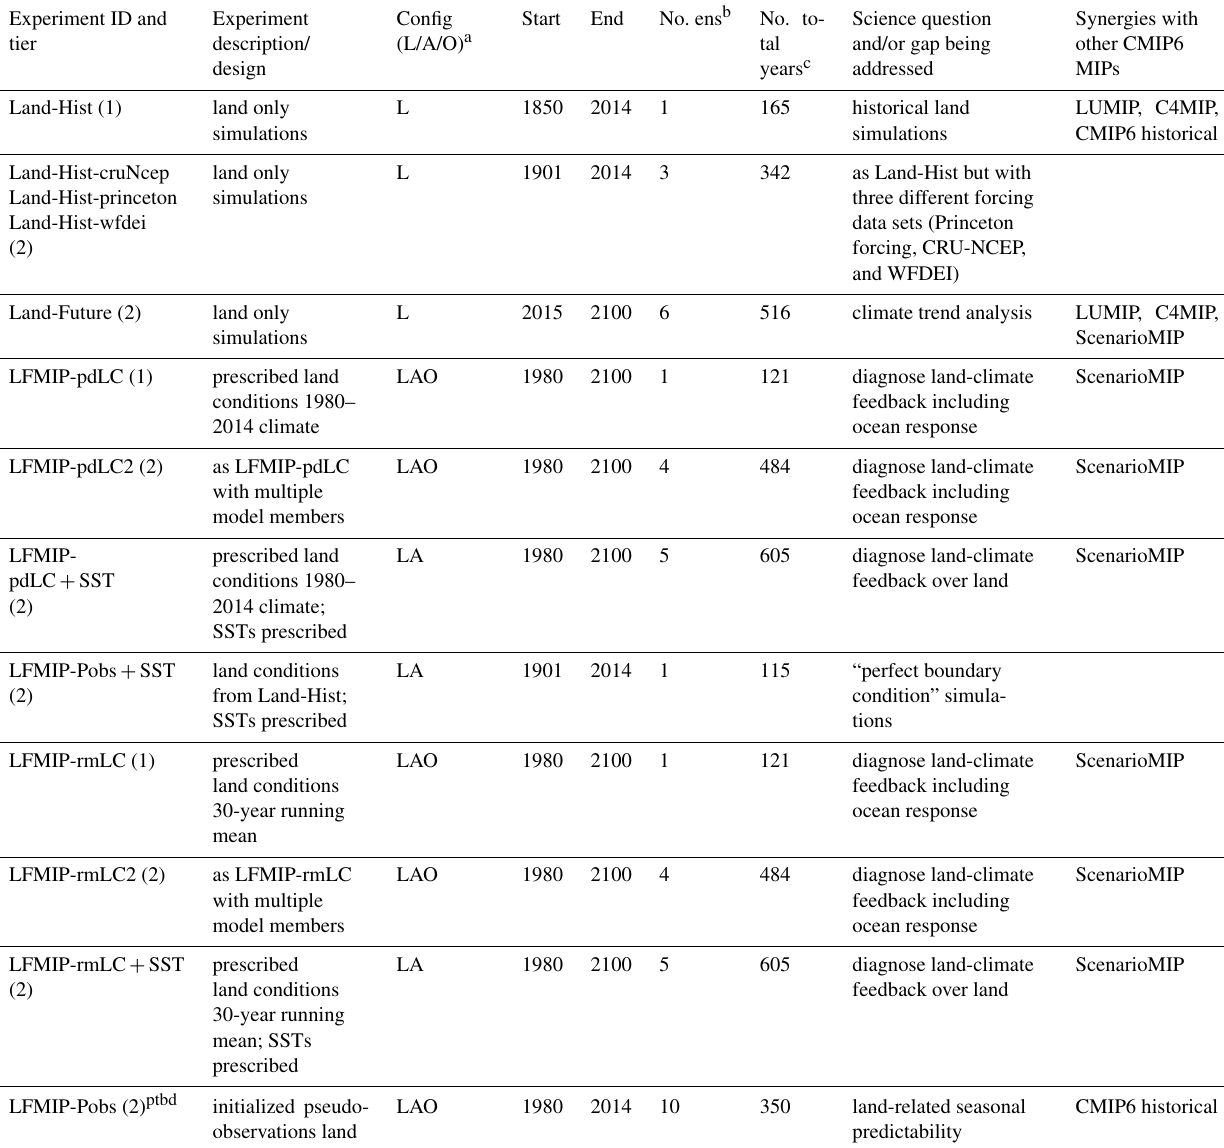
Table 1. Summary of LS3MIP experiments. Experiments with specific treatment of subsets of land surface features are not listed in this